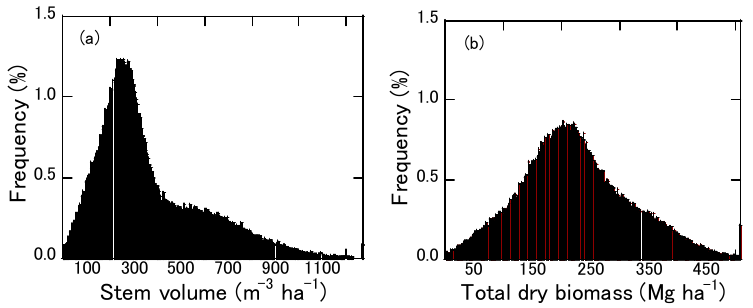
Figure 9. Frequency distributions of ( a ) SV and ( b ) TDB maps.